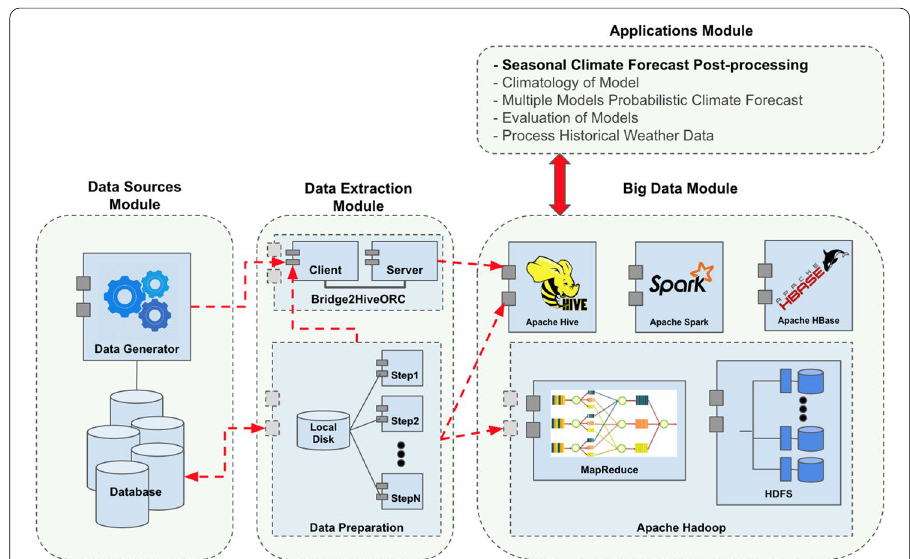
Fig. 13 The proposed conceptual model